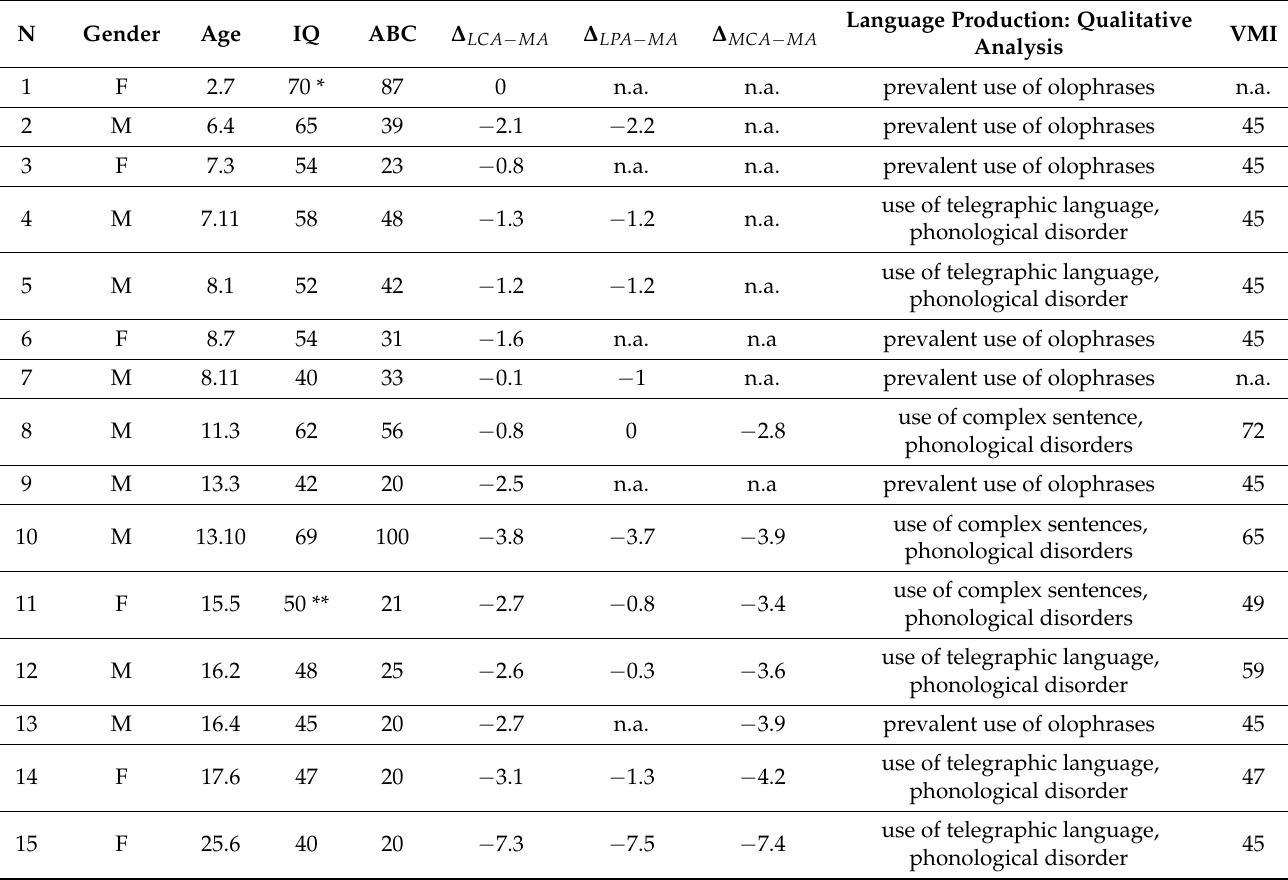
Table 1. Demographic features, cognitive abilities, adaptive behaviors, language profiles and visuo- motor integration abilities of studied